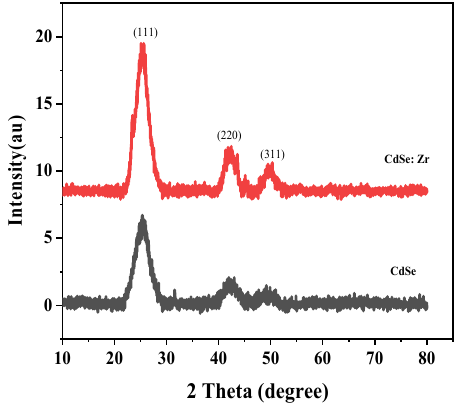
Fig. 1. XRD pattern of CdSe and Zr-CdSe